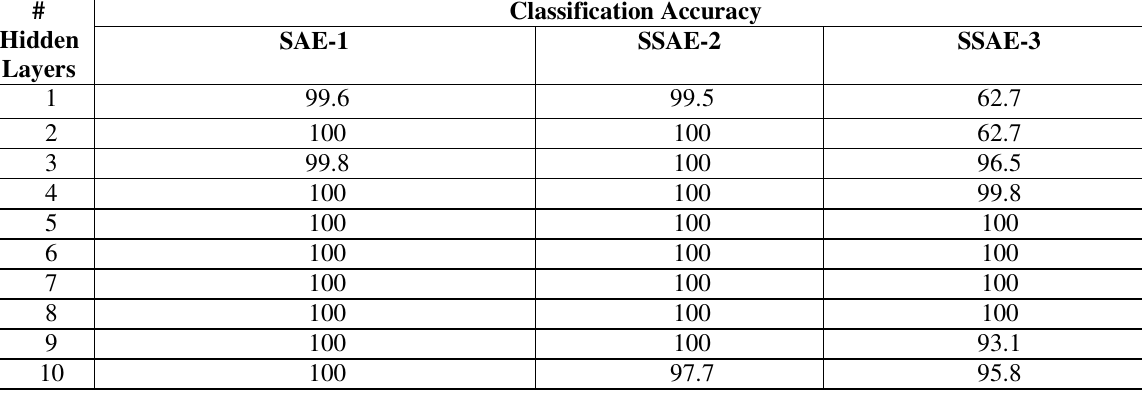
Table 5: Comparative Quantitative Performance Measures of different models for Breast Cancer Classifiers SR.